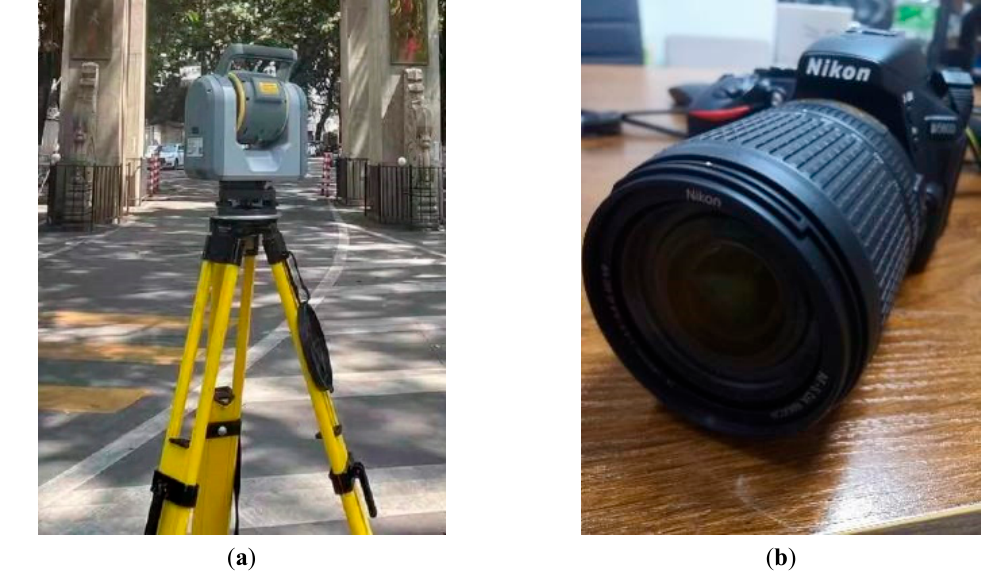
Figure 7. Survey equipment for experiment: ( a ) Trimble SX 10 scanner; ( b ) Nikon D5600 camera. Table 1. Parameters and their values used for the simulation of images.